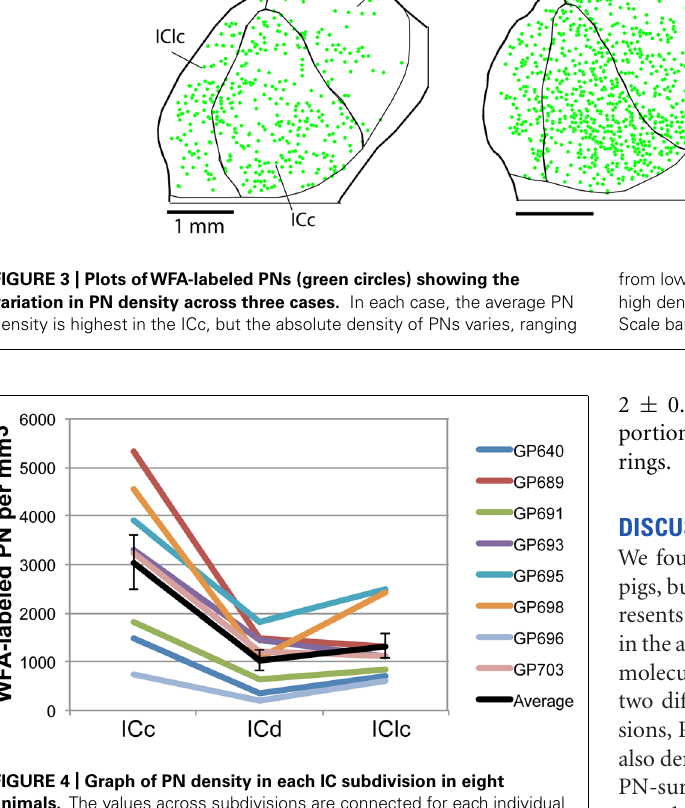
FIGURE 4 | Graph of PN density in each IC subdivision in eight animals. The values across subdivisions are connected for each individual case to facilitate comparisons between the cases; note that in all cases the ICc has the highest density of PNs. Black line indicates the average values and SEM. On average, ICc contains a higher density ofWFA-labeled PNs than ICd or IClc. Error bars =